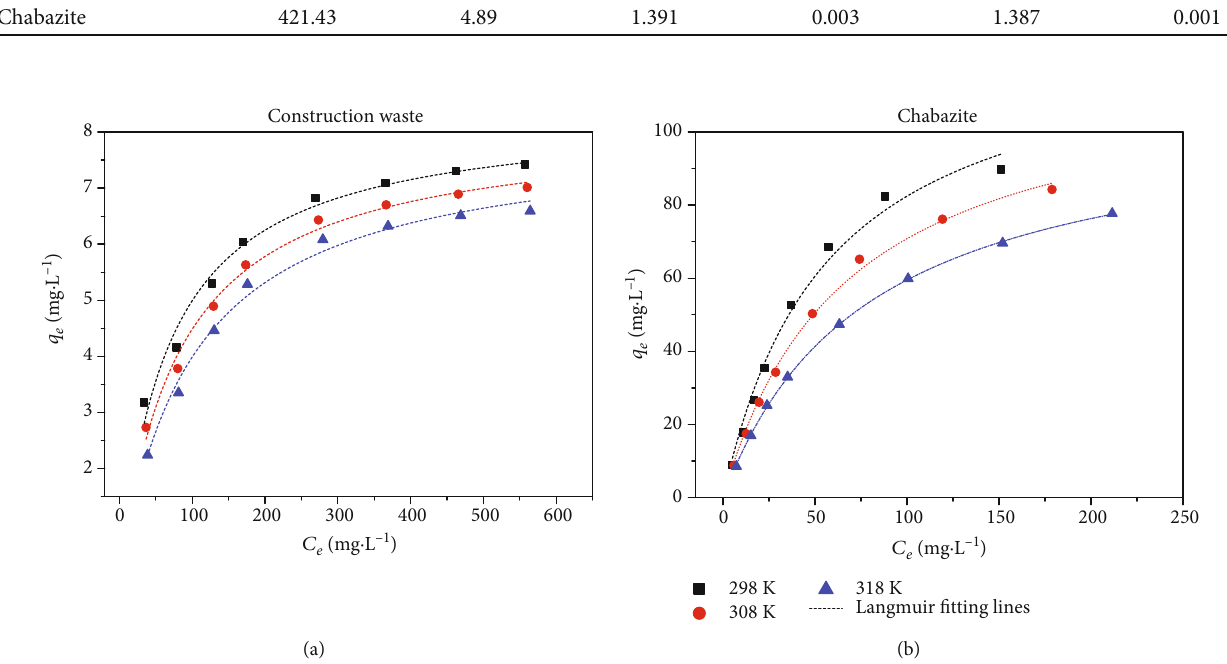
Figure 6: Adsorption isotherms of MB on (a) construction waste and (b)